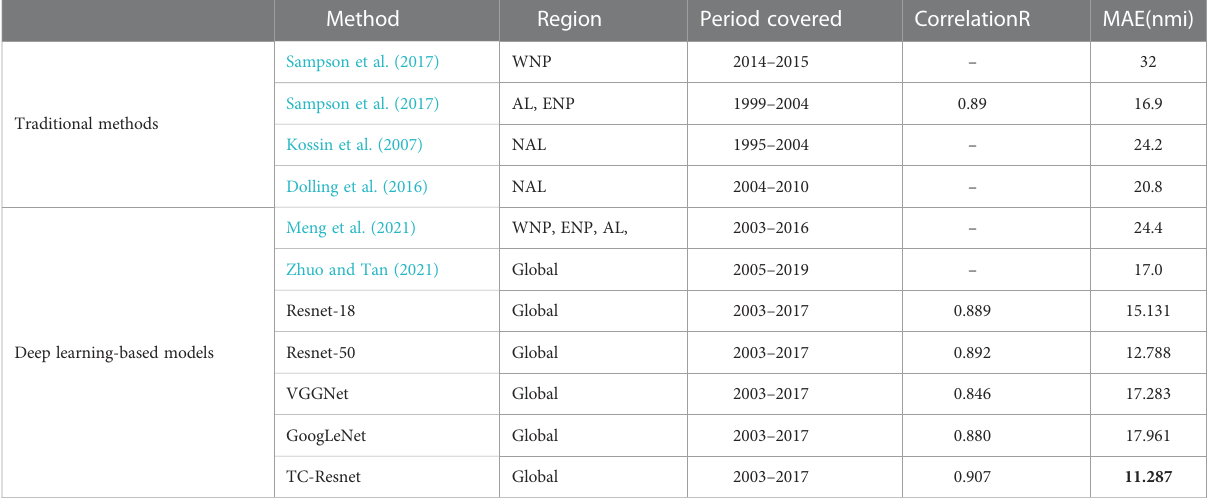
Method Region Period